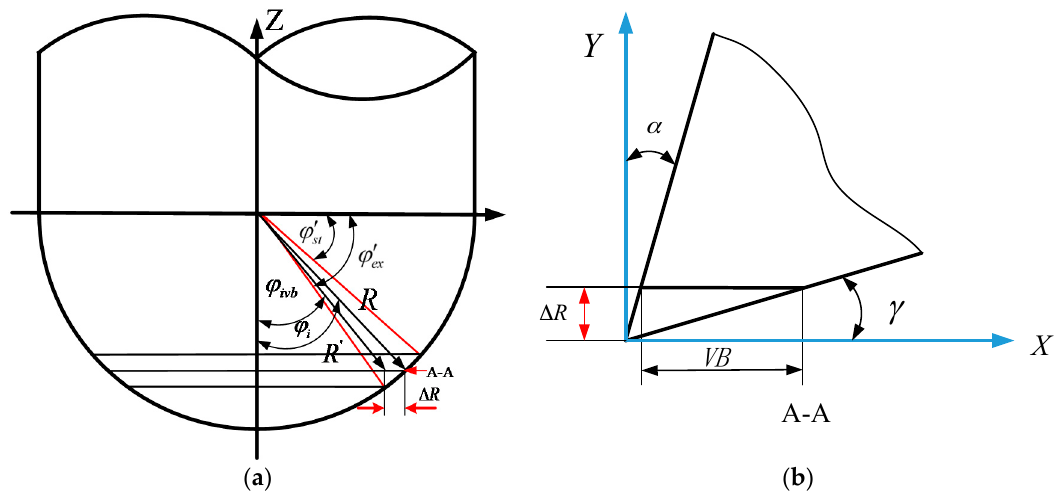
Figure 2. Schematic diagram of flank wear ( a ) the position change of cutting edge with tool wear; ( b ) the relationship between the radial radius variation and tool flank wear.